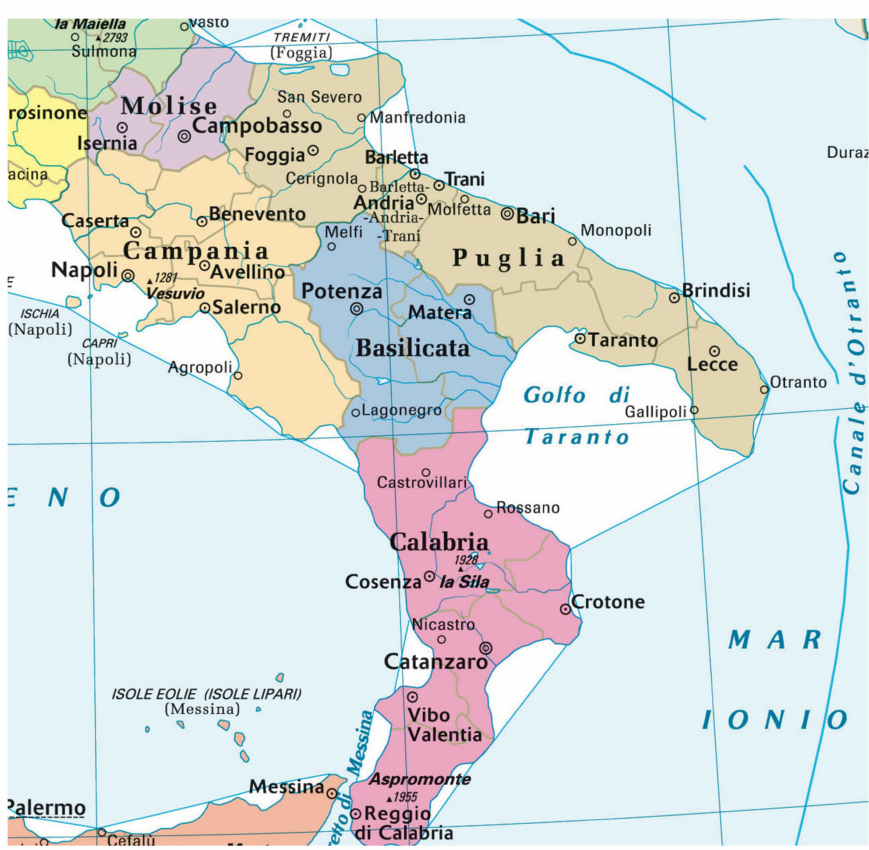
Figure 1. The five regions of the southern Italian peninsula (reproduced with permission from Atlante Geografico Mondiale, Milan, Italy: Touring Club Italiano,